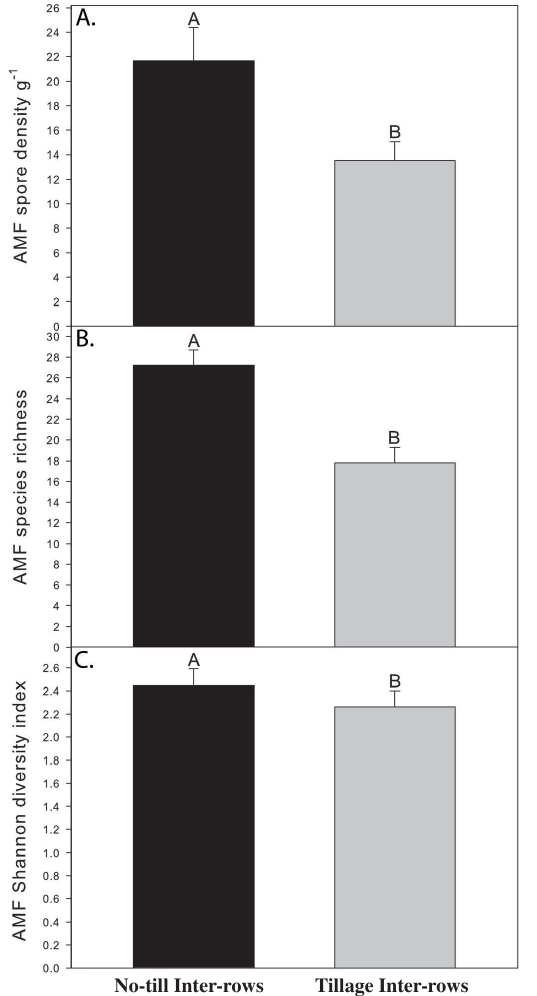
Fig. 1: AMF spore density, species richness and Shannon-Weaver diversity in no-tillage and conventional tillage inter-rows of two 39-years old “Pinot Gris” vineyards. 5